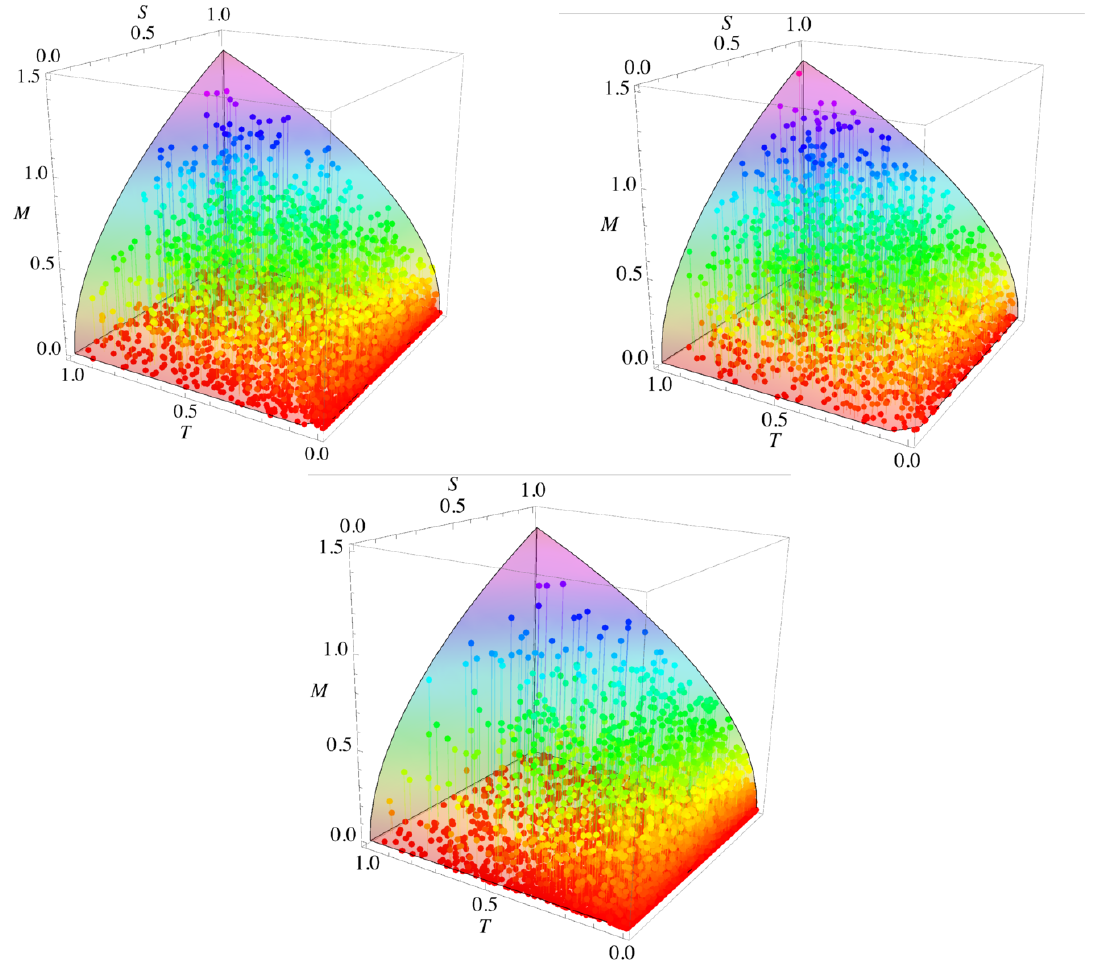
Figure 27 . Random points generated in the parameter space of the simpli(cid:12)ed model, compared with quadratic and quartic positivity bounds in the same space. Top left: quadratic condition from WW ; top right: quadratic condition from ZZ ; bottom: quadratic condition from WZ